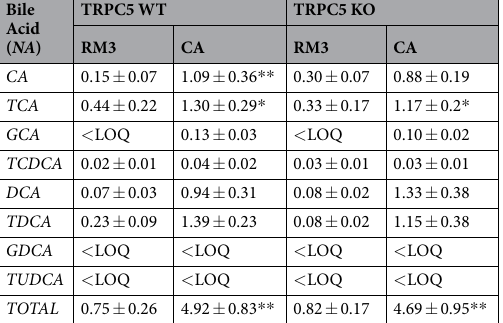
Table 1. Plasma Bile Acid profile. Primary and secondary plasma bile acids determined by LC-MS in WT and TRPC5 KO mice 21 days following chow- or CA-diet feeding. Results are mean ± S.E.M., n = 6–7. * P < 0.05, ** P < 0.01 vs control as determined by two-way ANOVA and Bonferronni Post Hoc tests. CA; Cholic acid, TCA; Taurocholic acid, GCA; glycocholic acid, TCDCA; Taurochenodeoxycholic acid, DCA; Deoxycholic acid, TDCA; Taurodeoxycholic acid, GDCA, Glycodeoxycholic acid, TUDCA; Tauroursodeoxycholic acid. NA; normalized area, LOQ; limit of